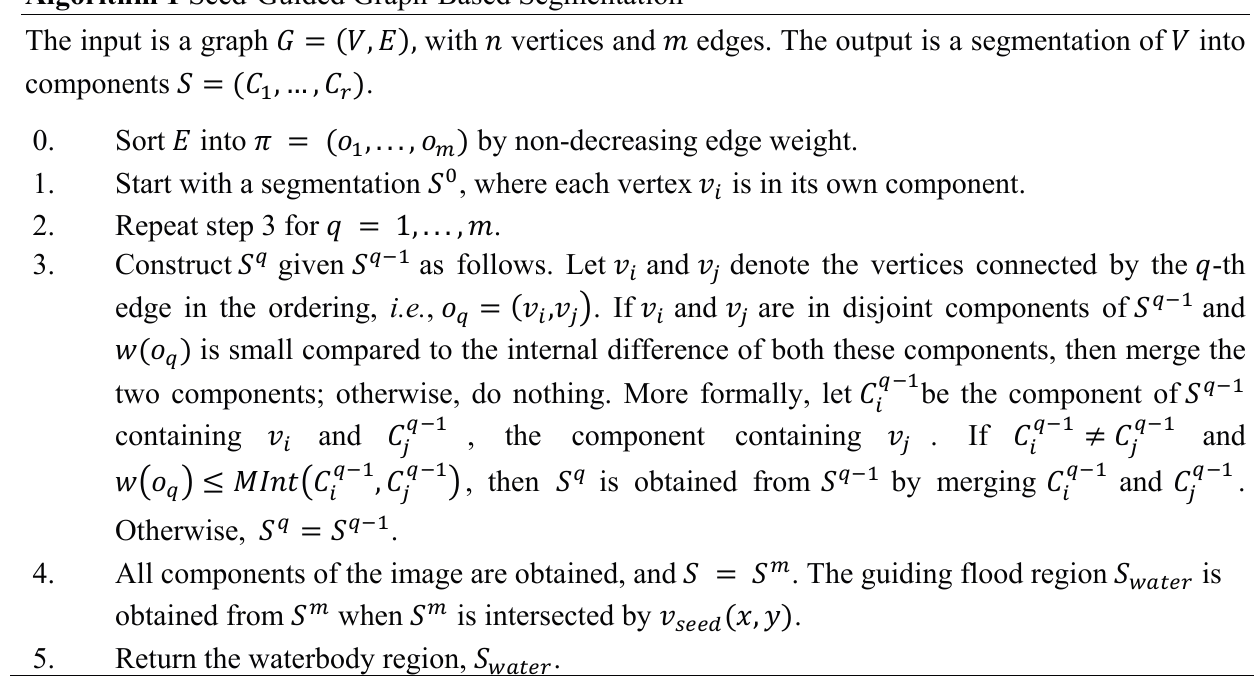
Algorithm 1 Seed-Guided Graph-Based